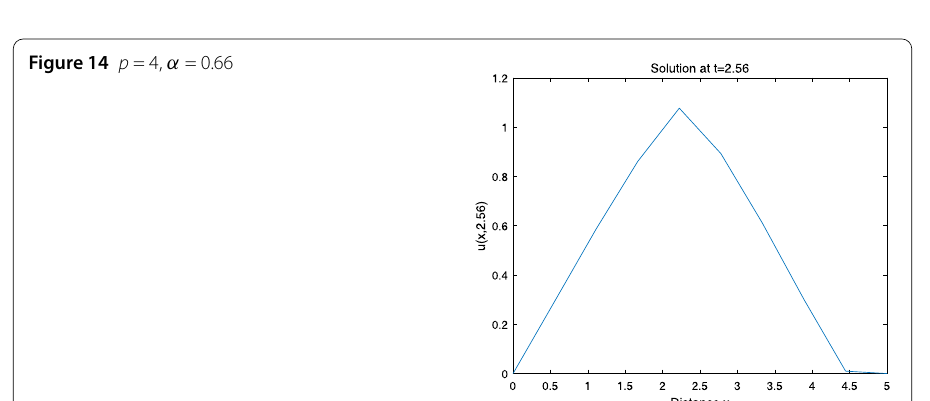
Figure 14 p = 4, α =